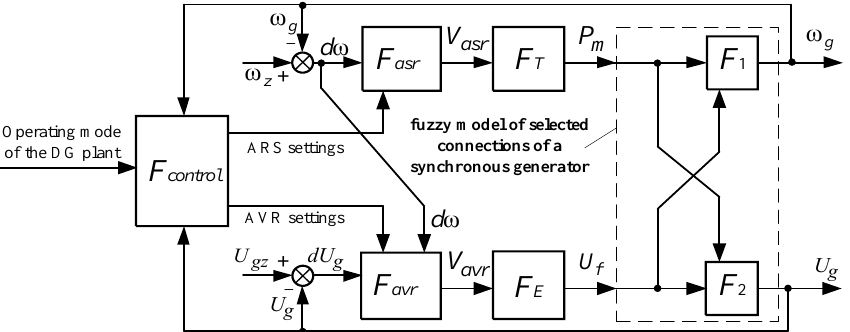
Figure 3. The structure of the DG plant digital twin: V asr , V avr are control signals from ASR and AVR; P m is the mechanical power at the turbine shaft; U f is the voltage on generator excitation winding; F control is the fuzzy controller model; F asr is the ASR fuzzy model; F avr is the AVR fuzzy model; F T is the turbine fuzzy model; F E is the generator exciter model; F 1 and F 2 are fuzzy models of generator-detected relations.